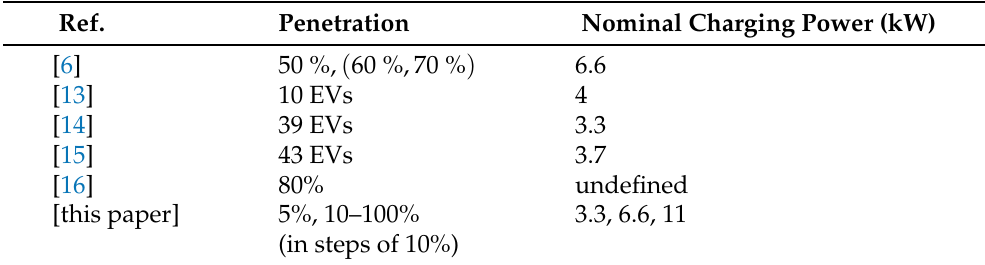
Table 1. An overview of literature on voltage-based charging control and the proposed study.